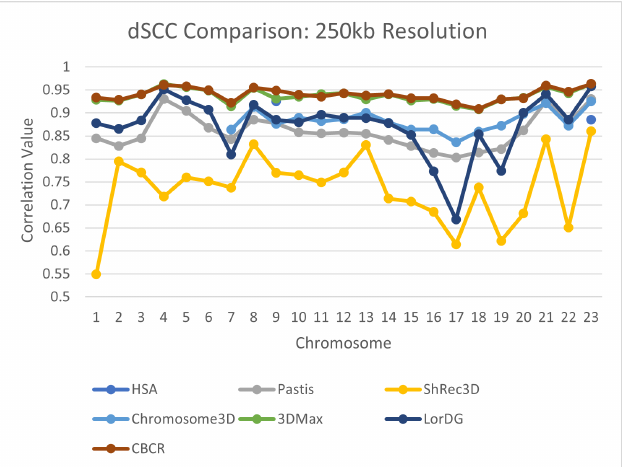
Figure 11. Comparison of dSCC between CBCR and other methods on chromosomes 1–23 at 250 kb resolution.